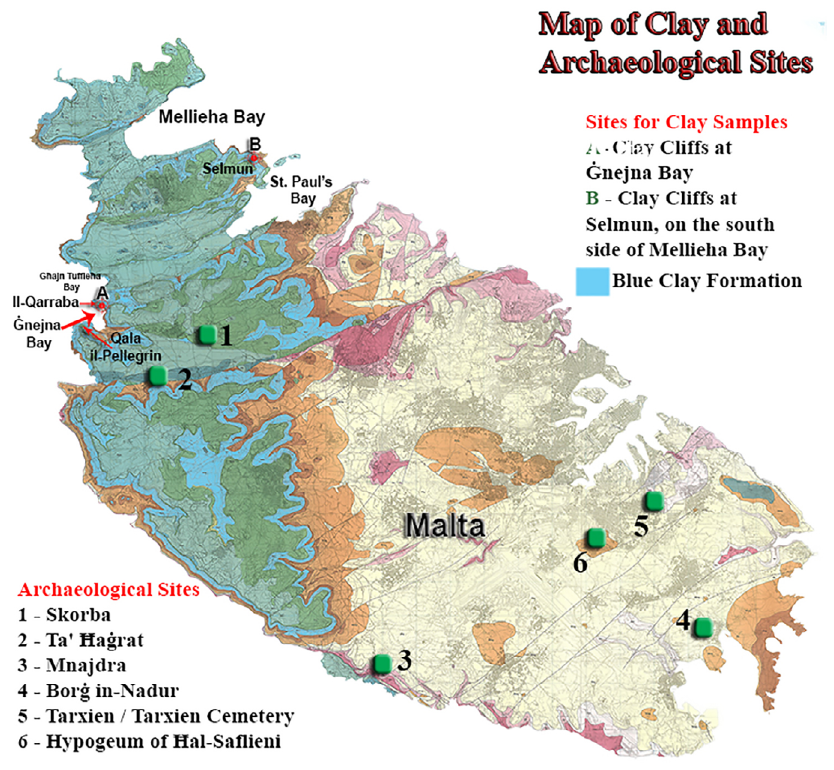
Figure 10. Map of the locations clay sources were sampled with archaeological sites on the island of Malta. (Adapted from